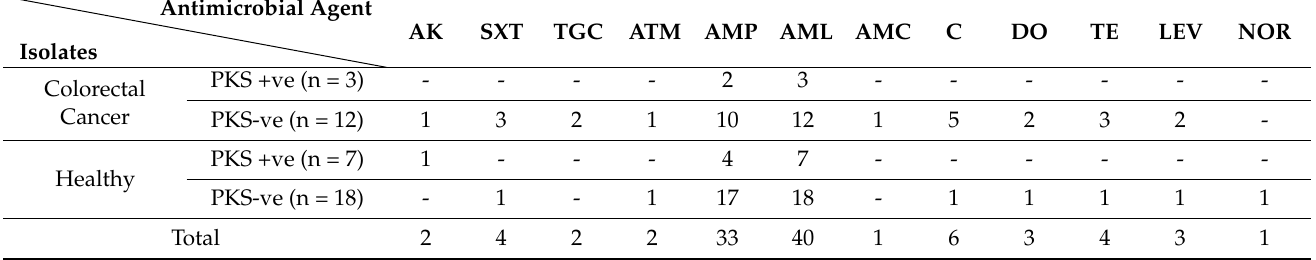
Table 4. Antibiotic Susceptibility Testing (AST) of K. pneumoniae Clinical Isolates.